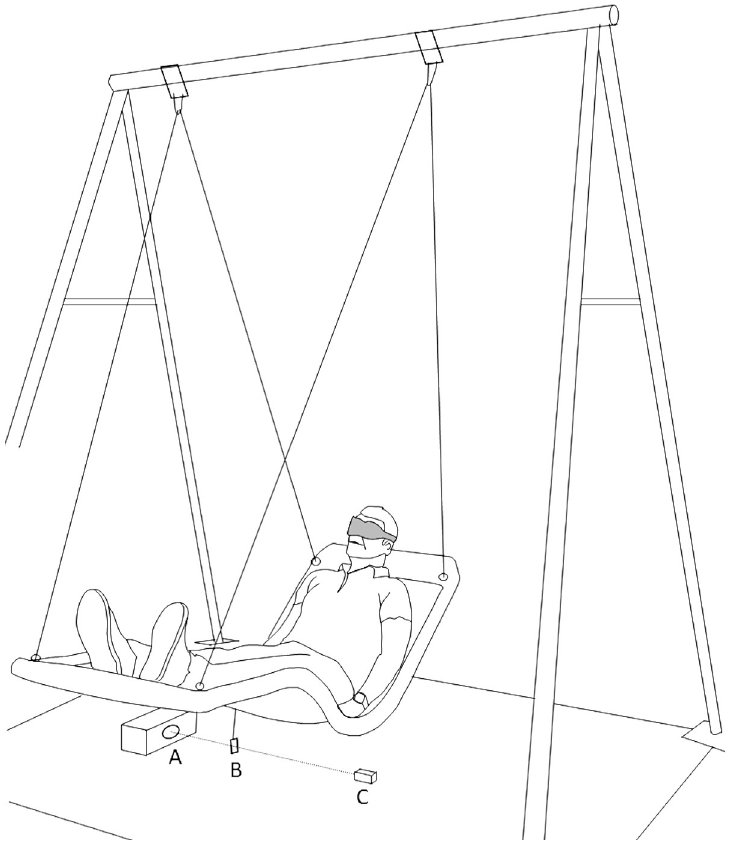
Fig 1. Experimental setup. The patient is installed on a swinging bed with eyes blinded by a mask. An electronic device (A) detects the bed’s movements and emits a beep at the beginning of each oscillation period. The movement detector is composed of an infrared emitter (A), a deflector (B) and a cover (C) placed under the bed. The cover edge was also used to measure deviation from the equilibrium position in acceleration threshold measurements. The speaker emitting the beep was placed inside the emitter box approximately 1.5 meters away from the subject’s